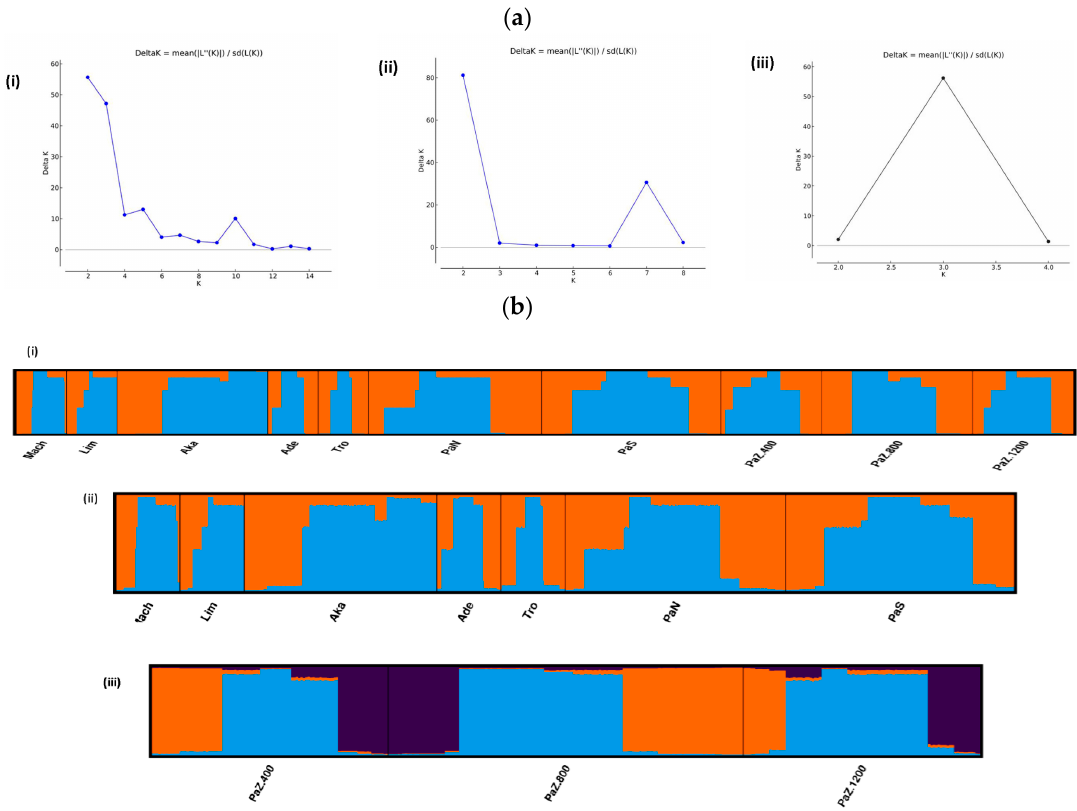
Figure 2. Bayesian cluster analysis of the optimum K clusters. ( a ) The optimal number of clusters ( K ) based on the Evanno method: ( i ) all sampled subpopulations, ( ii ) range-wide subpopulations, and ( iii ) altitudinal subpopulations. ( b ) Bar plot with individual mosquitoes represented as vertical bars colored in proportion to their assignment to clusters inferred at ( i ) all sampled subpopulations— K = 2, ( ii ) range-wide subpopulations— K = 2, and ( iii ) altitudinal subpopulation— K = 3.